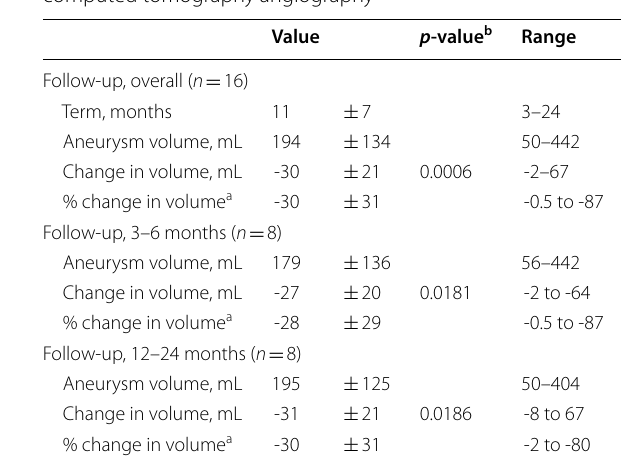
Table 2 Follow‑up aneurysm sac volume data based on computed tomography